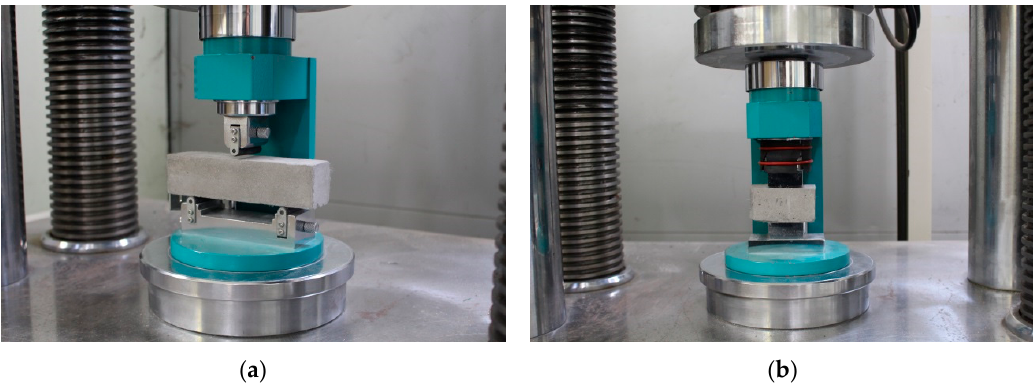
Figure 1. Set-up for mechanical properties testing—( a ) flexural strength; ( b ) compressive strength.